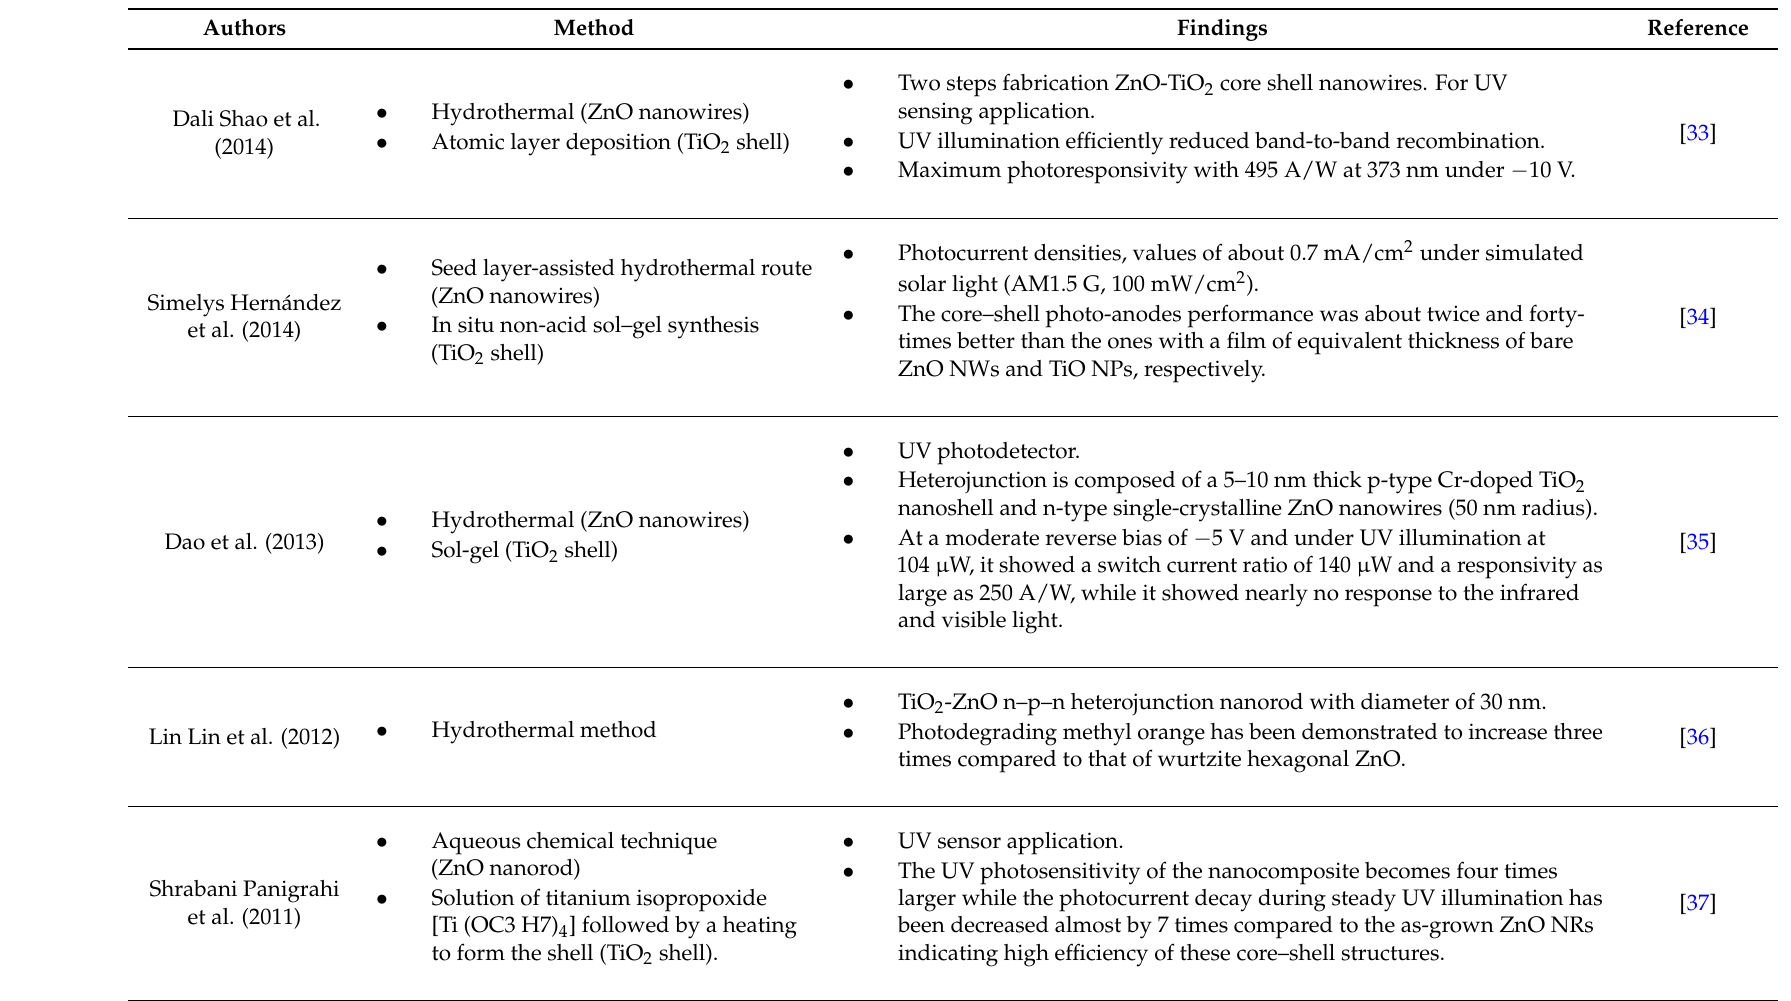
Table 1. The development of hybrid TiO 2 -ZnO formation based on different